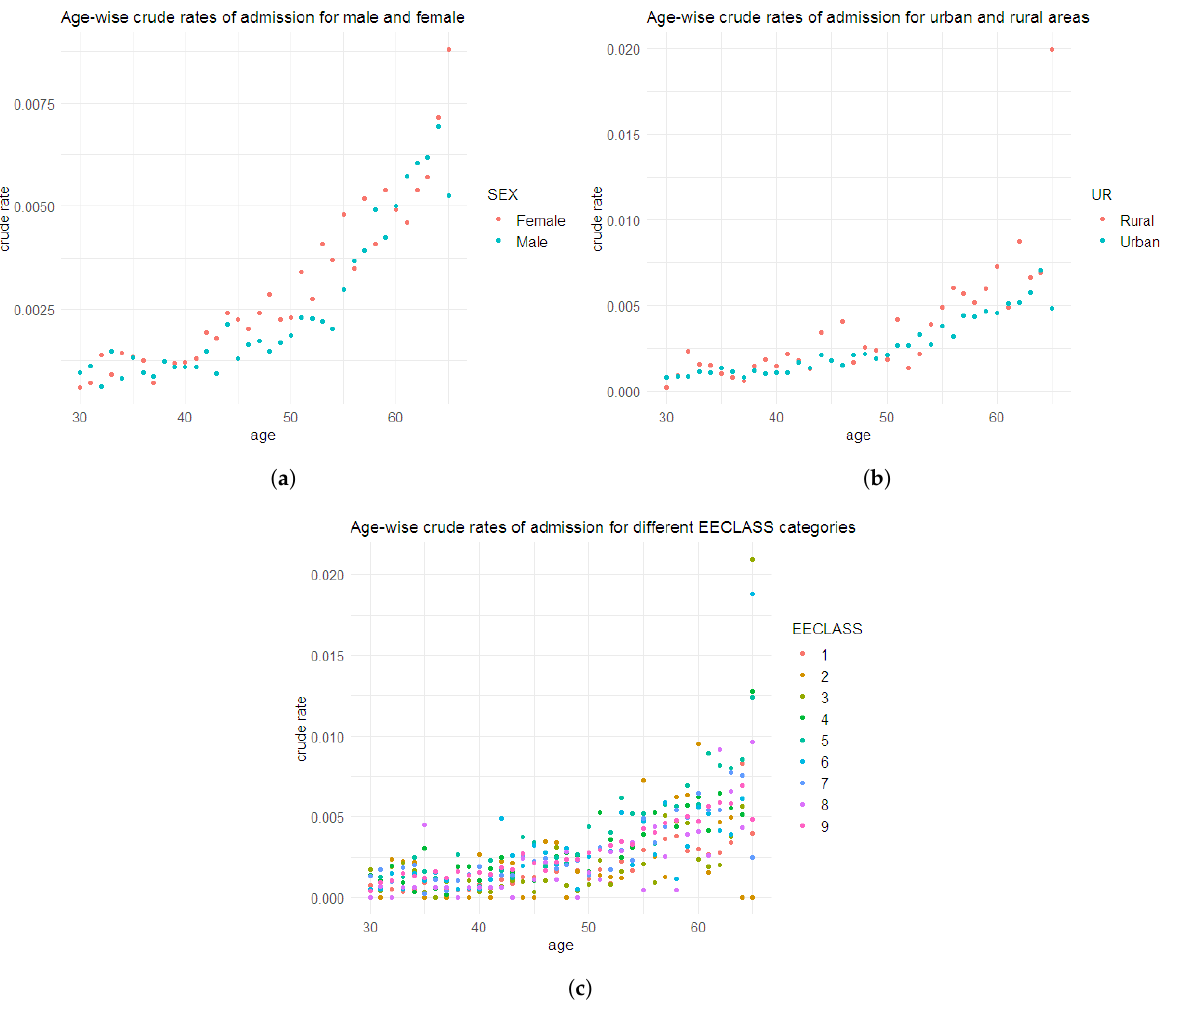
Figure 2. Age-wise crude rates of admission due to respiratory diseases: ( a ) male, female; ( b ) urban and rural areas; ( c ) categories of EECLASS. Table 2. Frequency of number of admissions related to respiratory diseases for individuals under the age range